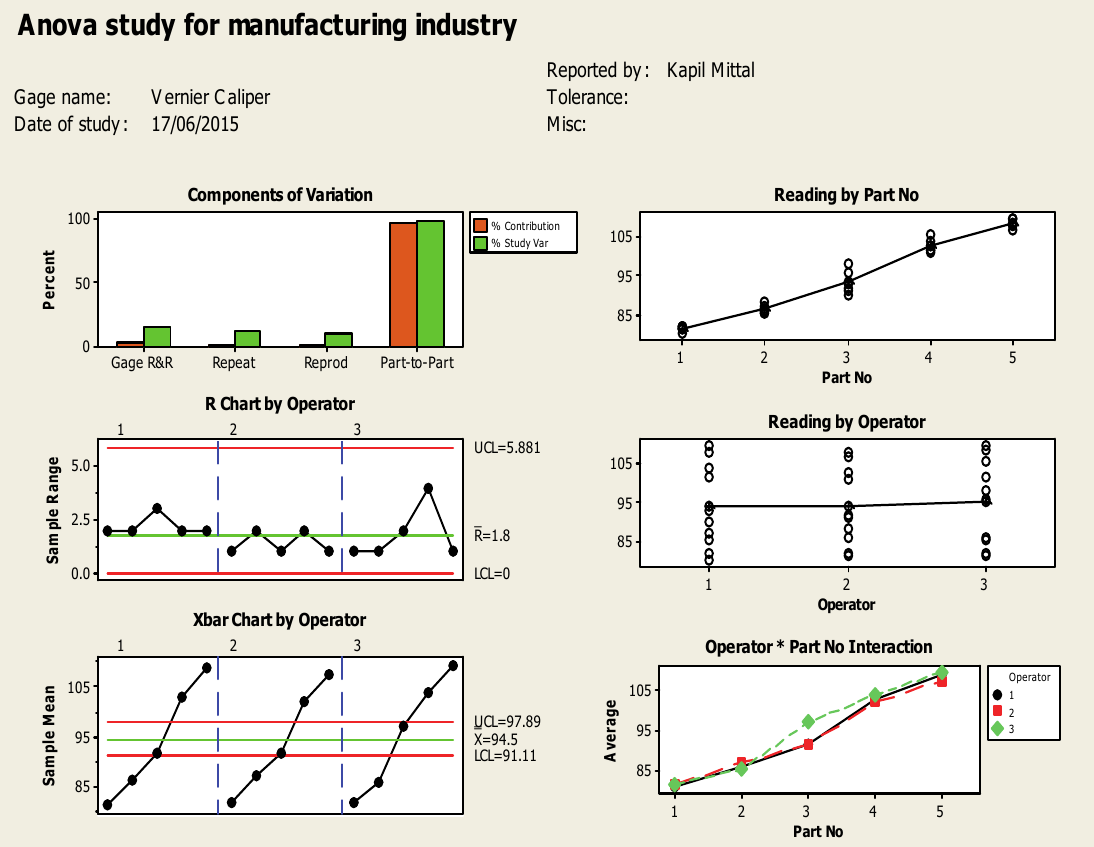
Fig. 3. Components of Variation (Manufacturing